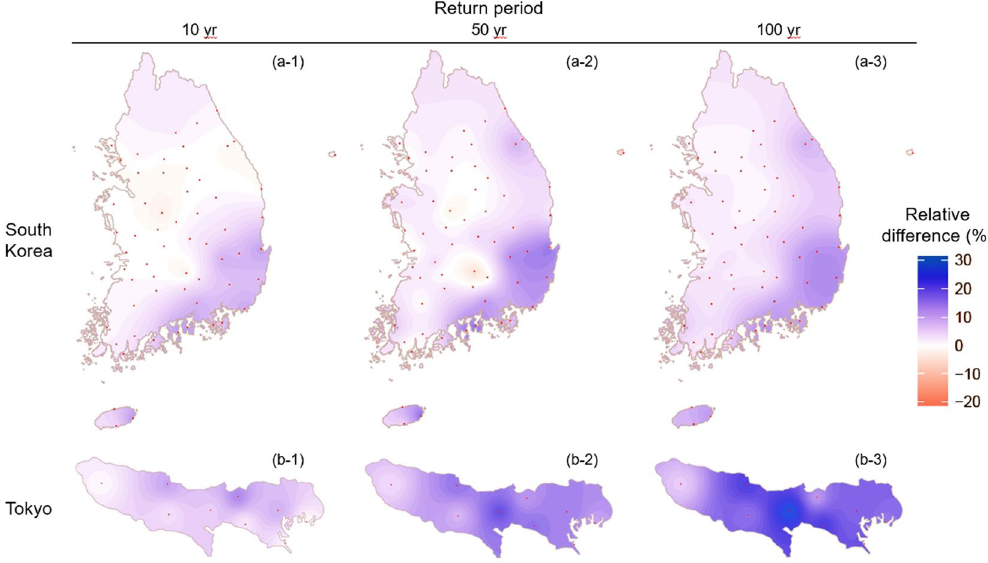
Figure 4. Relative percent differences (RPD = ( IGEV − GEV TOT )/ GEV TOT , %) of the quantiles estimated with the nonstationary GEV model between total rainfall ( GEV TOT ) and integrated rainfall ( IGEV ) for the 10-, 50-, and 100- yr return period over (a) South Korea and (b) Tokyo. Note that the Kriging method is used for interpolation; blue (red) shading indicates that the quantiles estimated with the IGEV model are larger (smaller) than the quantiles estimated with the GEV TOT model, and red points indicate rain gauge stations. The map were generated using software “R studio Desktop, [1.0.44 version],